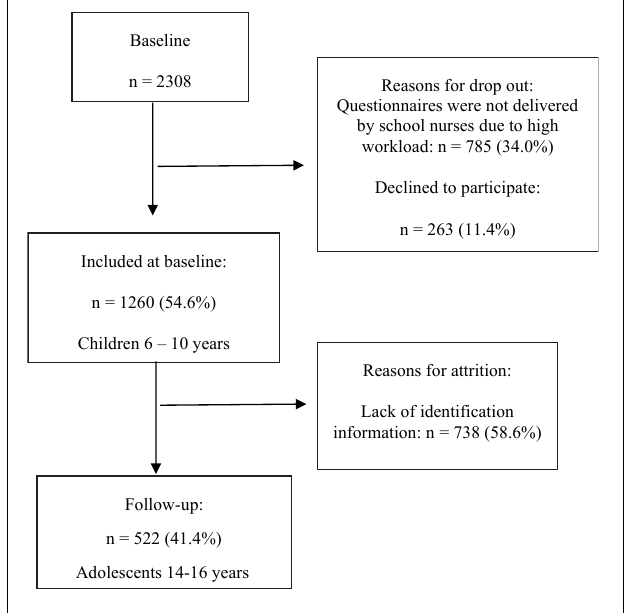
FIGURE 1 | Selection process at baseline and